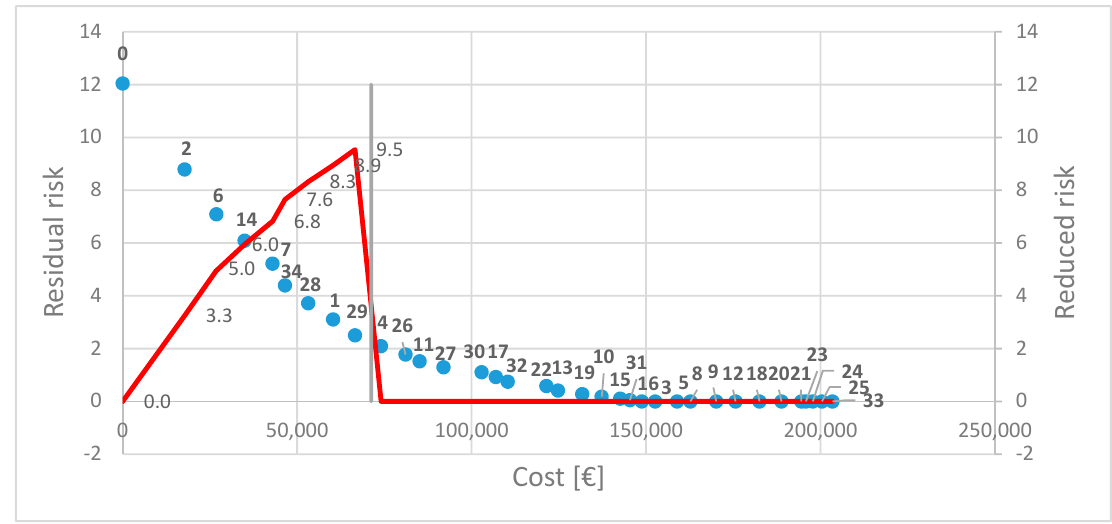
Figure 5. Example of cumulative risk reduction evaluated based on a specific available budget.